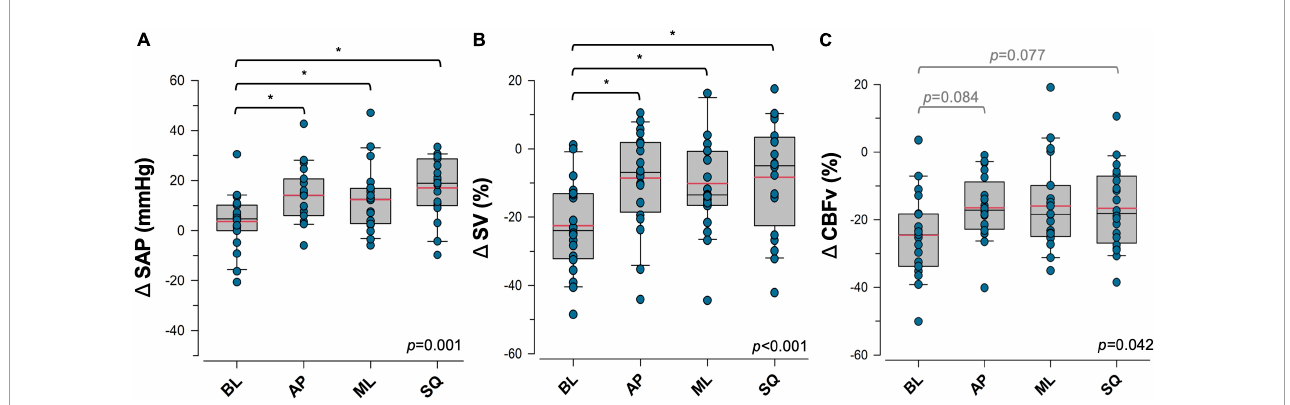
FIGURE2 Effects of postural sway on cardiovascular control. Responses to four patterns of sway in (A) systolic arterial pressure (SAP), (B) stroke volume (SV), and (C) cerebral blood flow velocity (CBFv) are shown. Data are presented as the response during each upright postural sway condition, relative to the supine resting values. Significant main effects are indicated in the bottom right corner of each plot. *Significantly different from baseline ( p < 0.05). Trends that were approaching significance are given in grey. Red = sample mean, black = sample median. BL, baseline (quiet standing) sway; AP, anterior-posterior sway; ML, mediolateral sway; SQ: square